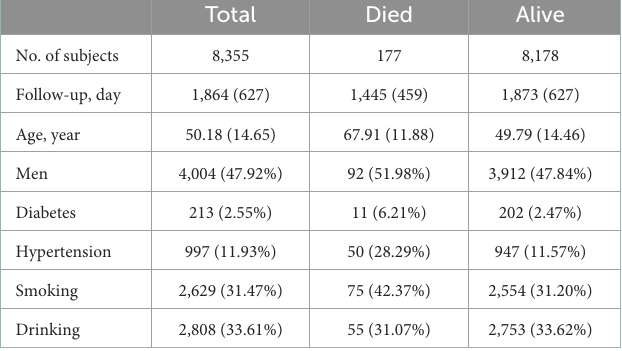
TABLE 1 Baseline characteristics of the study sample stratified by mortality